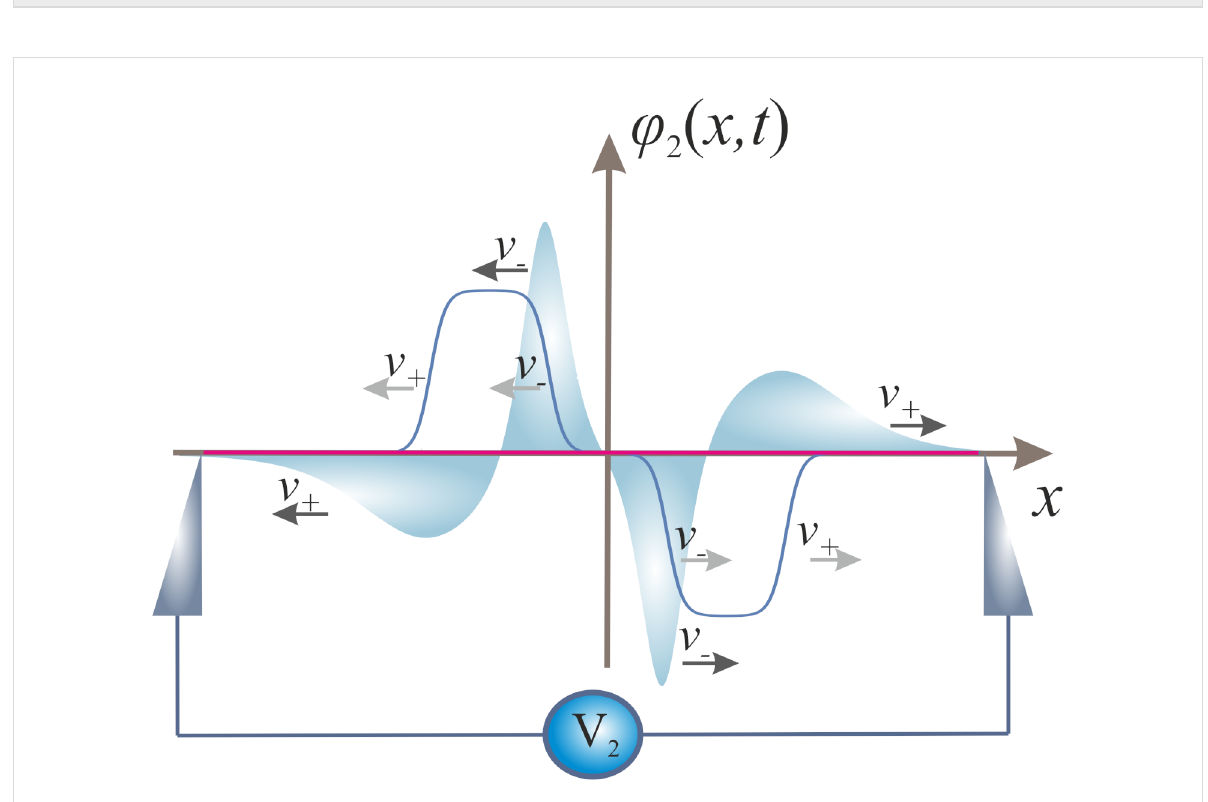
Figure 4: Time-dependent phase configurations at t = 0 (red) and t > 0 (blue) together with propagating voltage pulses in the second of the two capac- itively coupled superconducting nanowires generated by a QPS event in the first